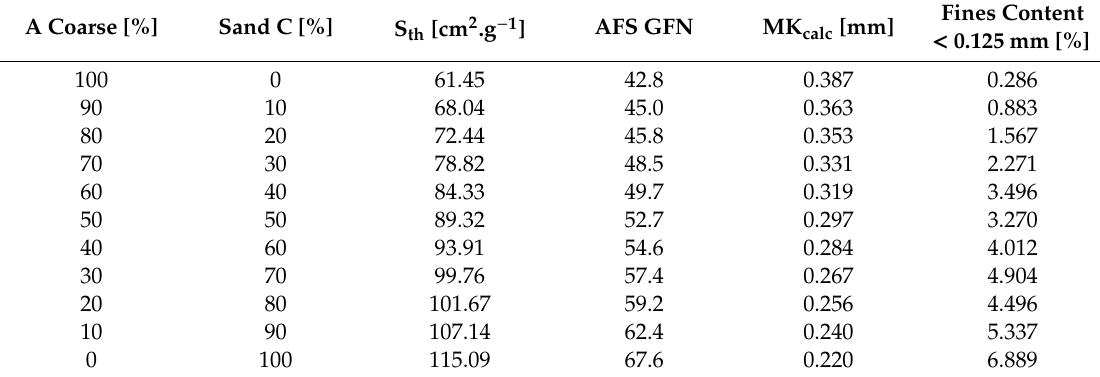
Table 4. Basic properties of sands A coarse and C.